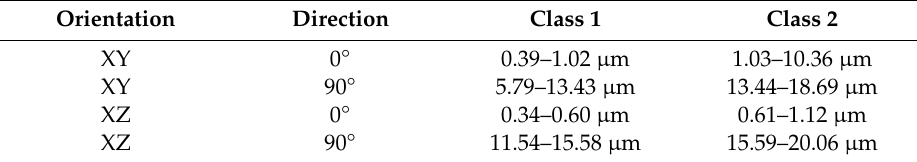
Table 7. Values used to establish the classes needed to perform data processing at WEKA.